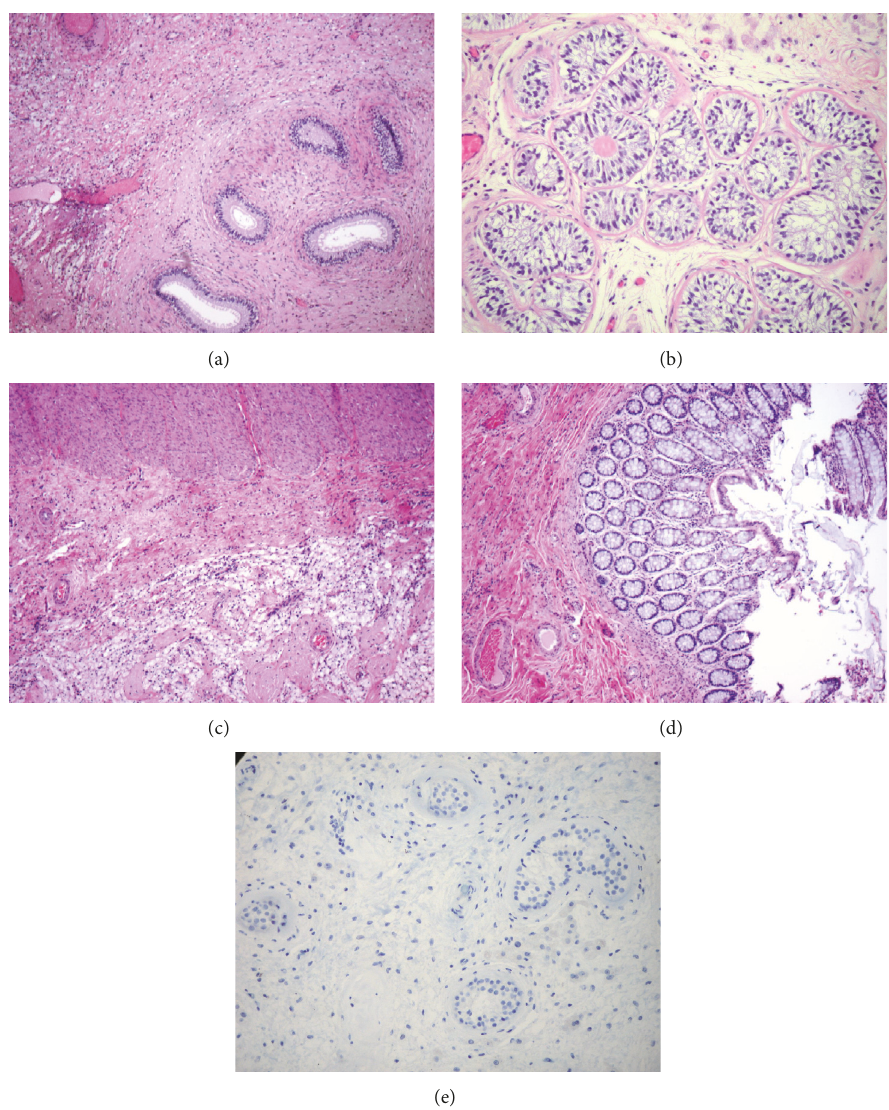
Figure 5: Retroperitoneal mass, excision. Nonviable tumor with extensive hyalinization and xanthogranulomatous reaction, and epididymis (a) (H&E, × 40); testicular parenchyma with extensive tubular atrophy, Sertoli cell hyperplasia, and clusters of small seminiferous tubules with pseudostratified Sertoli cells. Some tubules show Sertoli cell-produced basement membrane-like material inside the hypoplastic tubules (b) (H&E, × 200); colonic wall adjacent to nonviable tumor showing xanthogranulomatous reaction (c); colonic mucosa with no pathologic changes (d) (c and d: H&E, × 40). Immunoperoxidase stain with antibody against OCT 3/4 shows absence of germ cell neoplasia in situ in atrophic tubules (e) (DAB and hematoxylin counterstain, ×